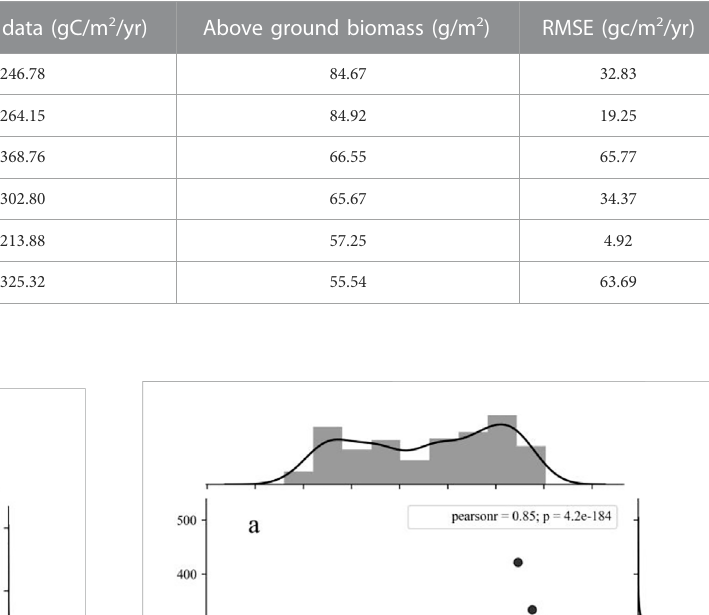
TABLE 2 CENTURY model veri fi cation.